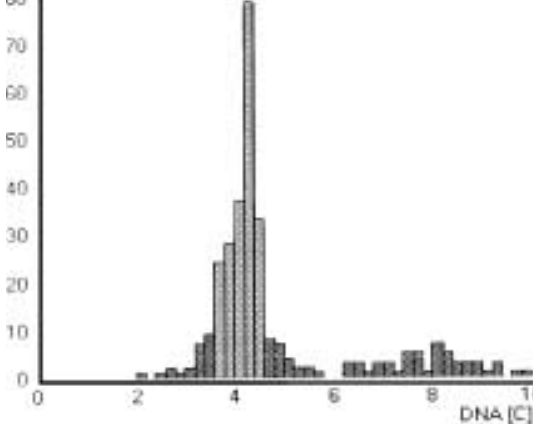
2003/25-4/remmerbach.htm.